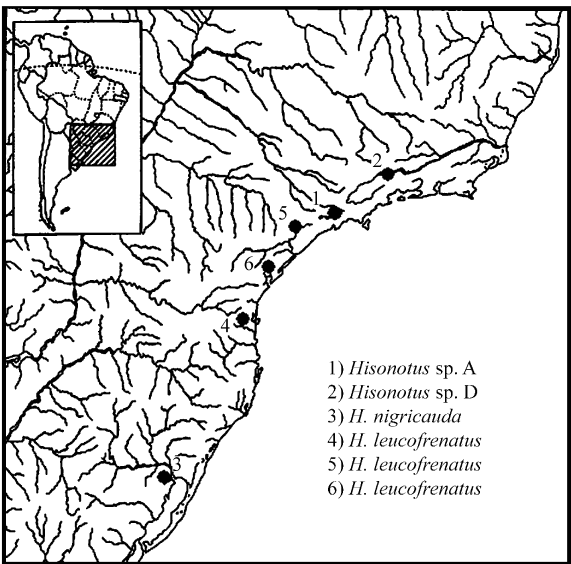
Figure 1 - Map showing the sites where the Hisonotus samples were col- lected. 1) Paraitinga river, Salesópolis, São Paulo State; 2) Grande stream, Pindamonhangaba,SãoPauloState;3)Guaíbariver,EldoradodoSul,Rio Grande do Sul State; 4) Cavalo stream, Jaraguá do Sul, Santa Catarina State; 5) Poço Grande stream, Juquiá, São Paulo State; 6) Marumbi river, Morretes, Paraná State. The numbers 5 and 6 correspond to the collecting sites of H. leucofrenatus studied by Andreata et al . (1993).